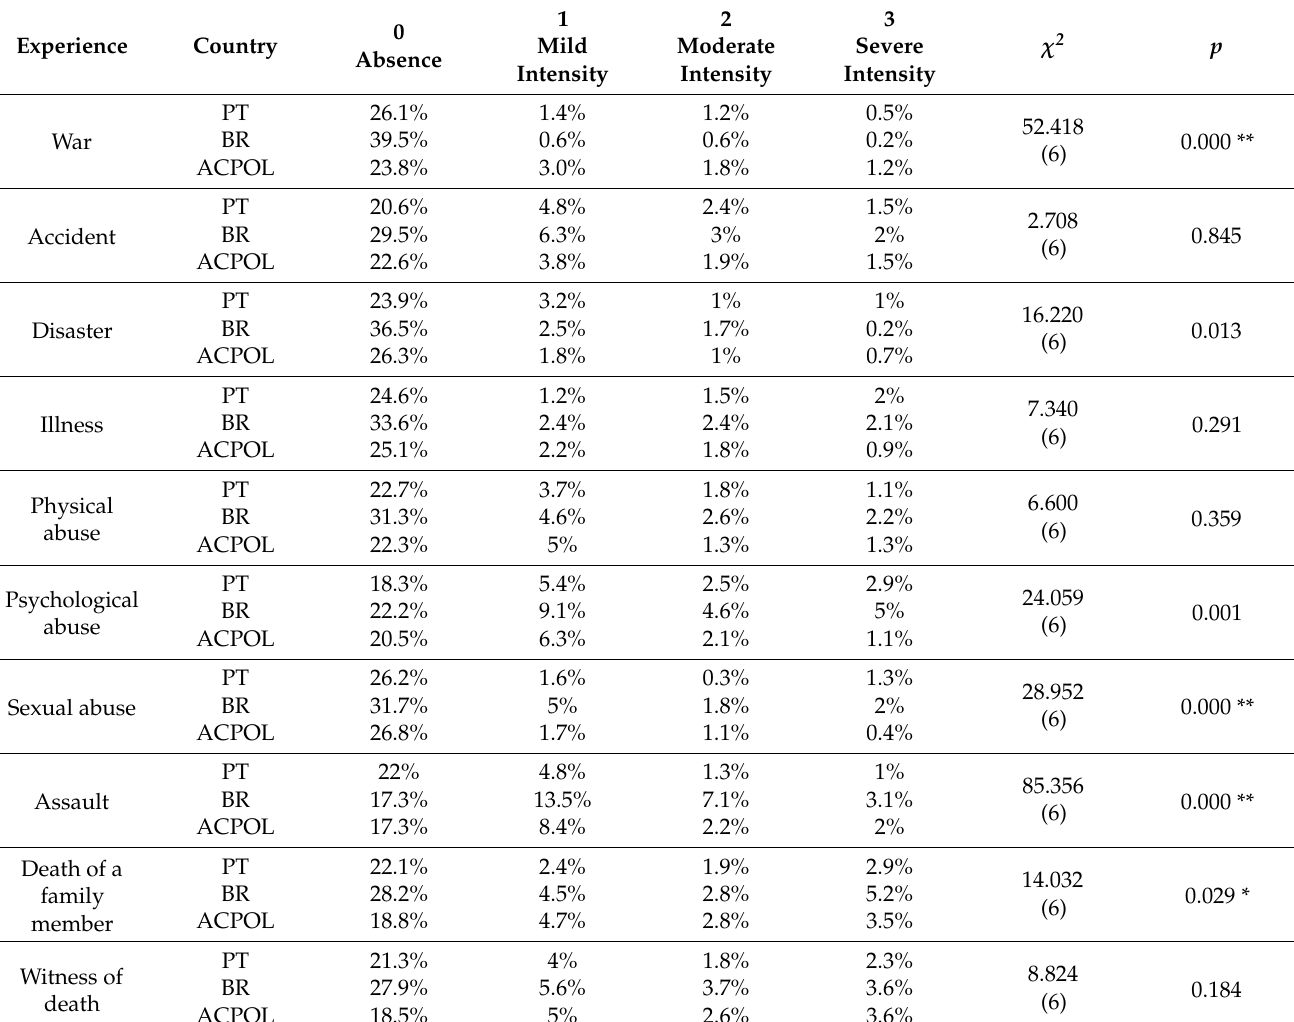
Table 2. Traumatic experiences by country of